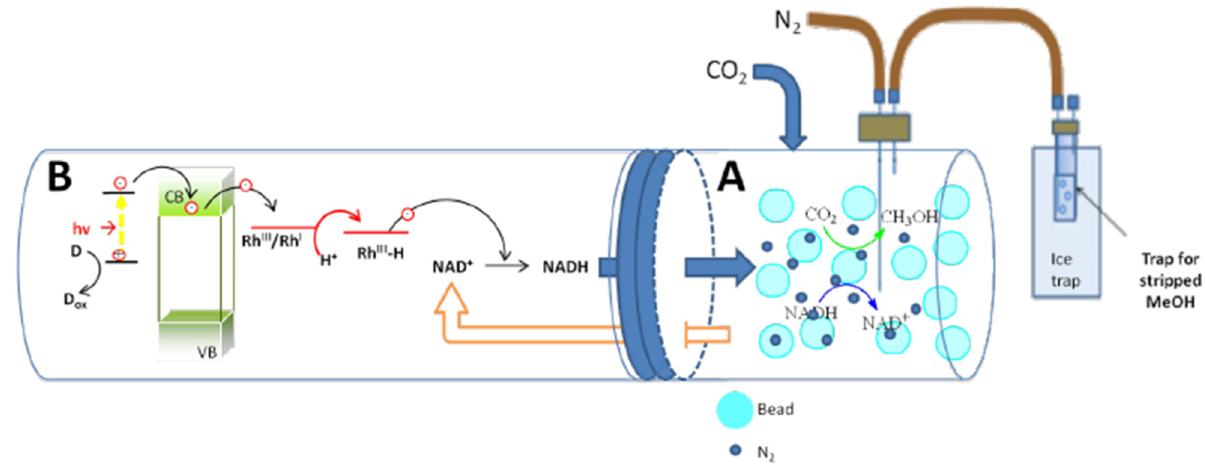
Figure 7. Biocatalytic reduction of CO 2 to CH 3 OH via a photocatalytic reactor system [74]. Challenges and Limitations of Biocatalytic CO 2 Reduction in Photocatalytic Reactors